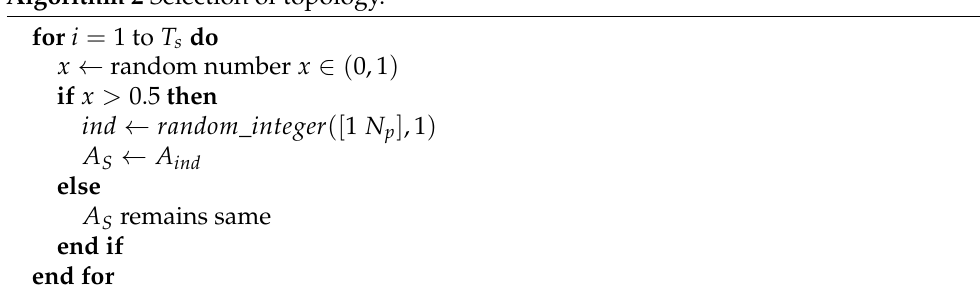
Algorithm 2 Selection of topology.